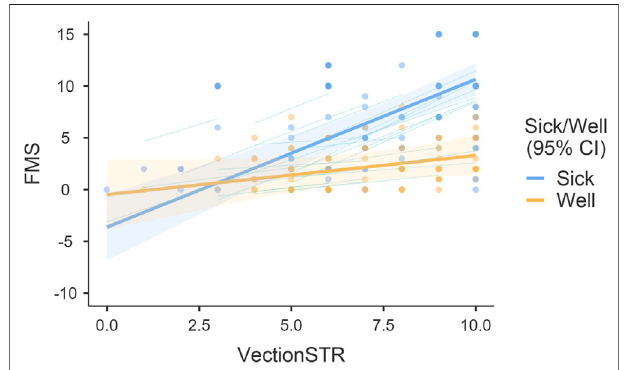
FIGURE 6 | Modelled non-linear (exponential) relationships between vection strength (VectionSTR) and cybersickness severity (FMS) as a function of sick/well